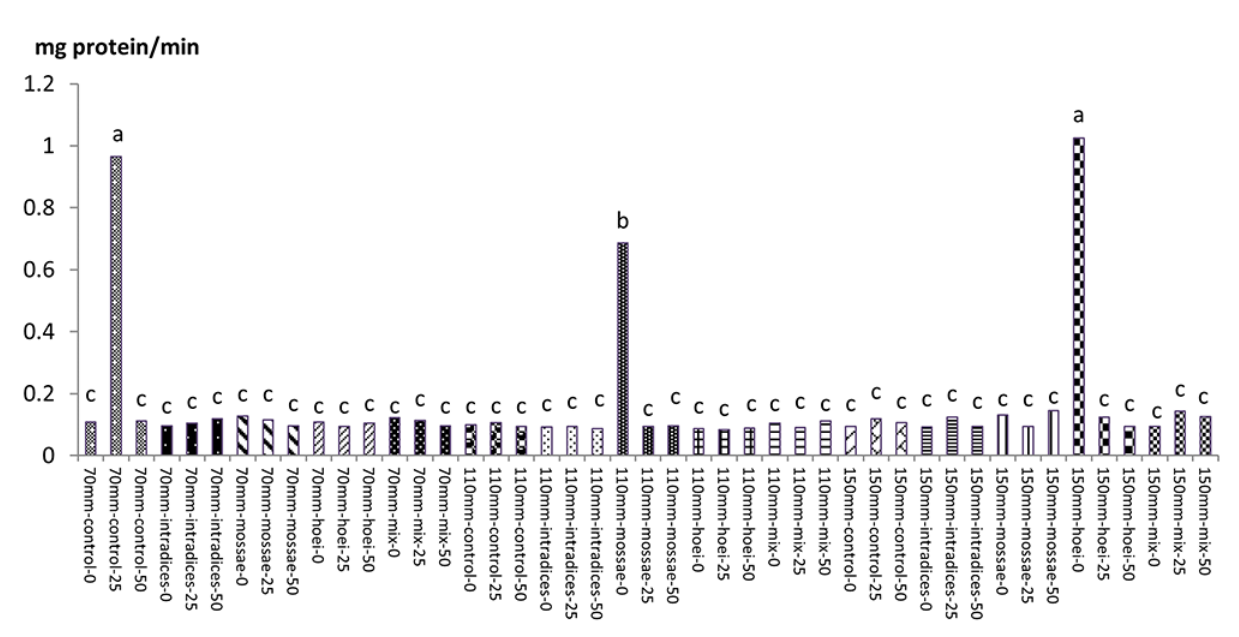
Figure 14 Effect of arbuscular mycorrhization and P fertilizer levels under different irrigation regimes on peroxidase